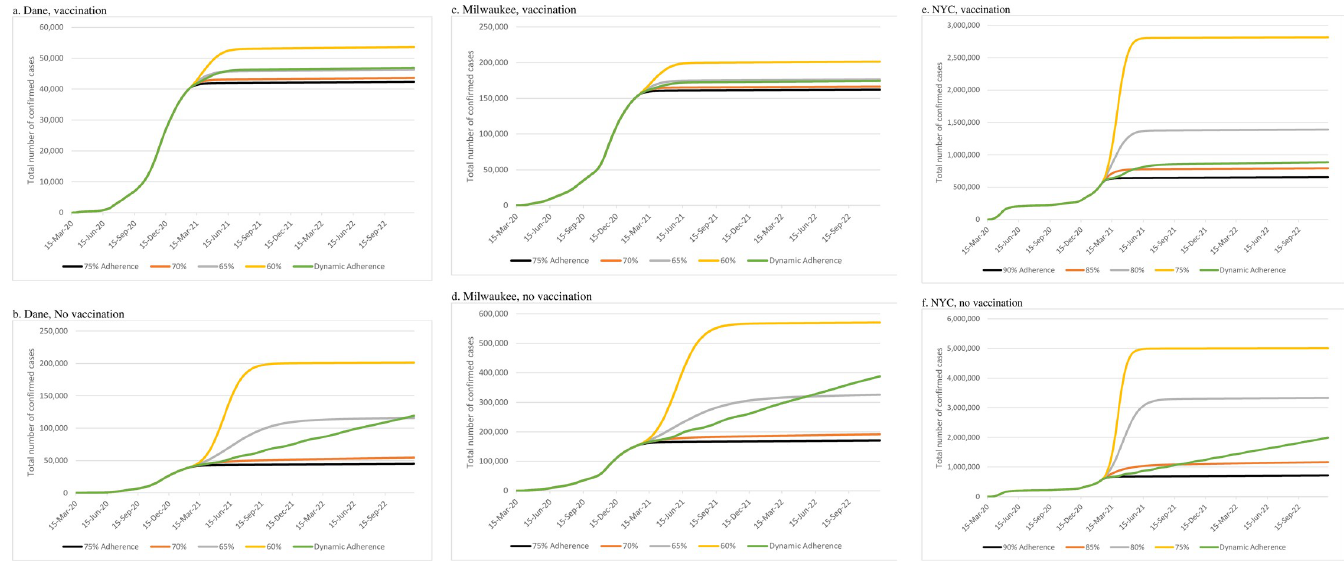
Fig 2. Impact of vaccination and adherence to nonpharmaceutical interventions (NPIs) on the number of cases over time.